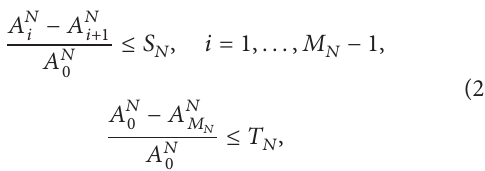
(iii) 𝑇 𝑁 , maximum percentage of total cut area, from a novel